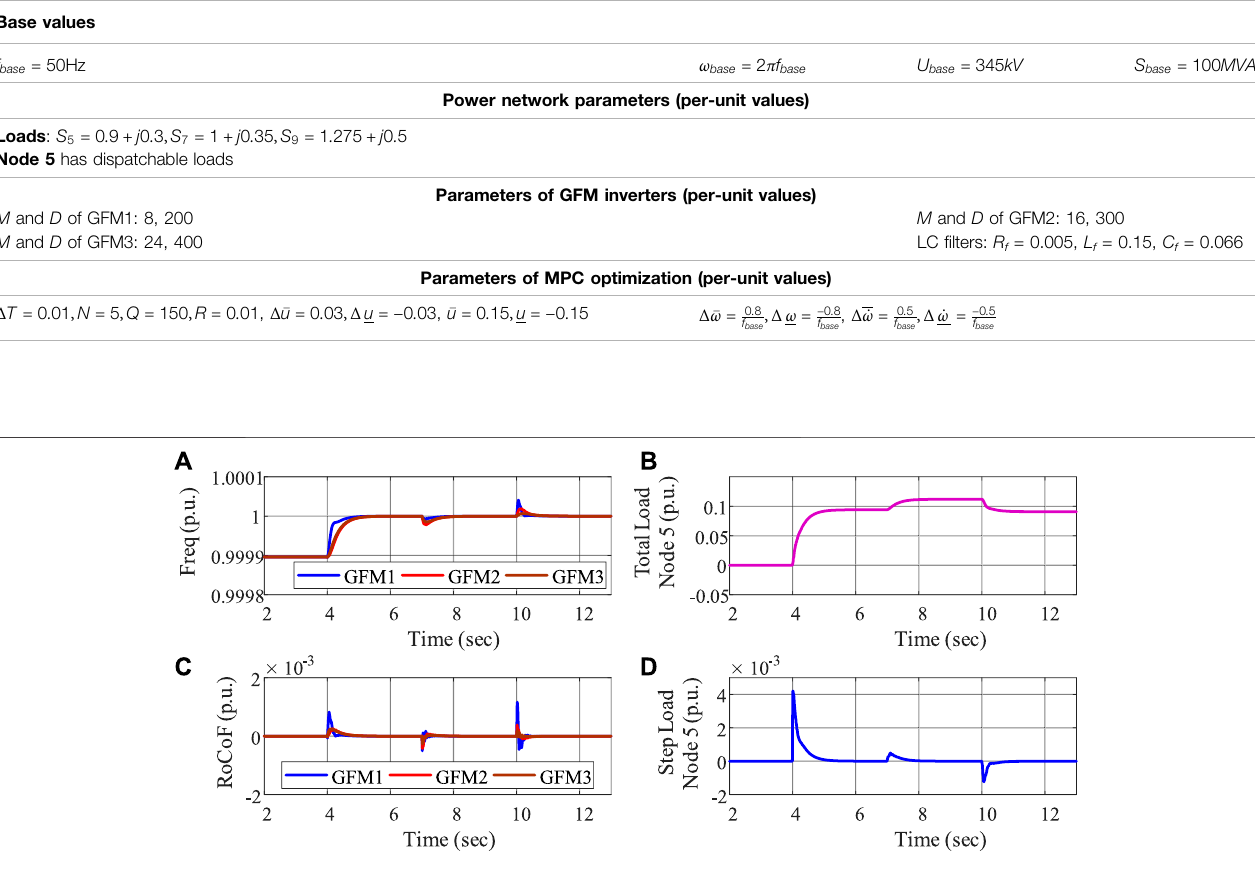
FIGURE 3 | Load-frequency response: (A) frequency, (B) total load decrease, (C) RoCoF, and (D) load ramping.